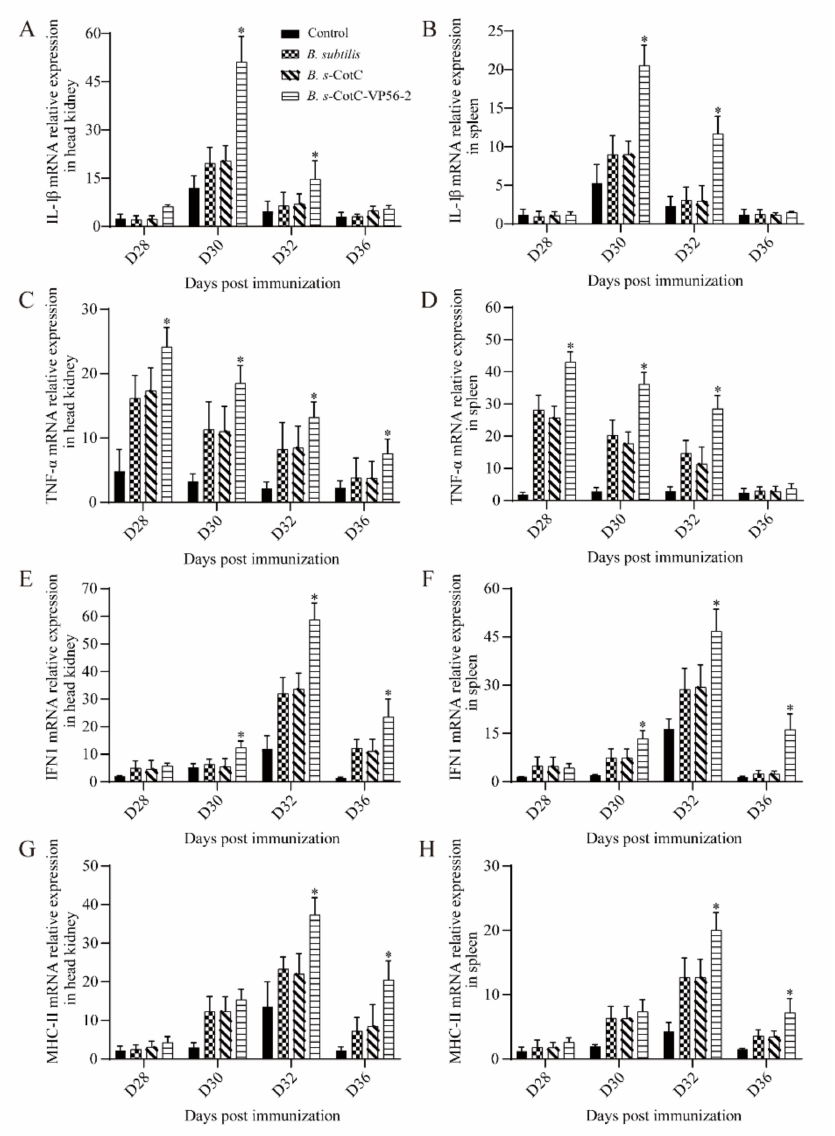
Figure 6. The mRNA expression pattern of representative important immunomodulatory and effector genes in head kidney and spleen tissues. Check IL-1 β ( A , B ), TNF- α ( C , D ), IFN1 ( E , F ) and MHC-II ( G , H ) transcripts by qRT-PCR. For an internal reference gene, 18S rRNA was used. Data are expressed as mean ± SD, and values that are significantly different from the control are indicated by asterisks (one-way analysis of variance, * p <